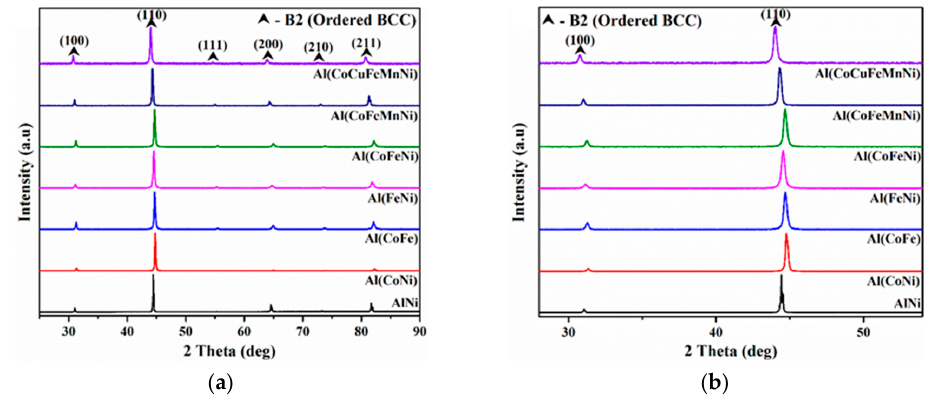
Figure 5. ( a ) X-ray diffractograms of pseudo-binary multicomponent alloys homogenized at 1373 K for 144 h showing the ordered BCC (B2) structure. ( b ) Slow scanned X-ray diffractograms showing a superlattice reflection (100).